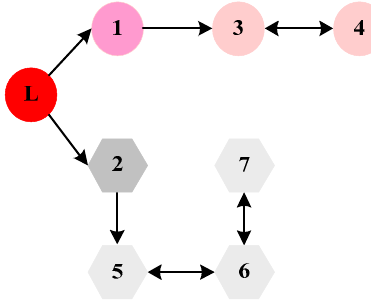
Figure 4. MAV/UAVs interaction topology.